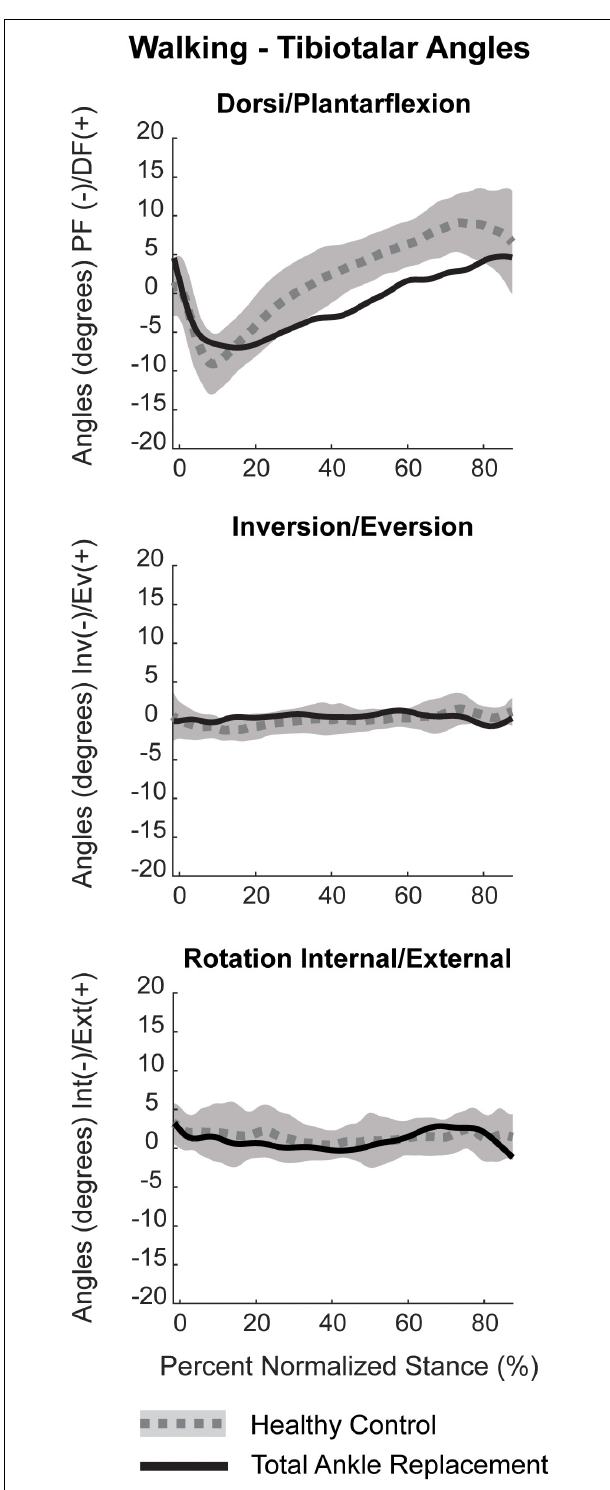
FIGURE 10 | Planar tibiotalar kinematics (dorsi/plantarflexion, inversion/eversion, and internal/external rotation) for the TAR participant compared with confidence intervals of healthy controls analyzed using DF during overground walking. Walking kinematics are normalized to percent stance from heel strike to toe